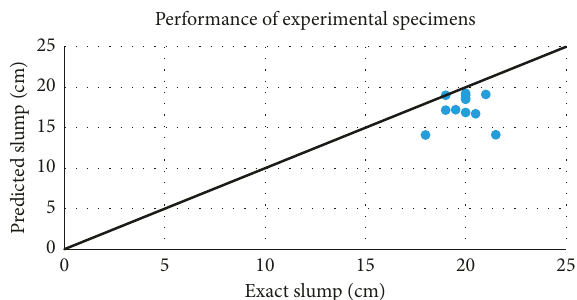
Figure 15: Comparison of exact slump with SPNN-predicted slump for the 12 experimental concrete